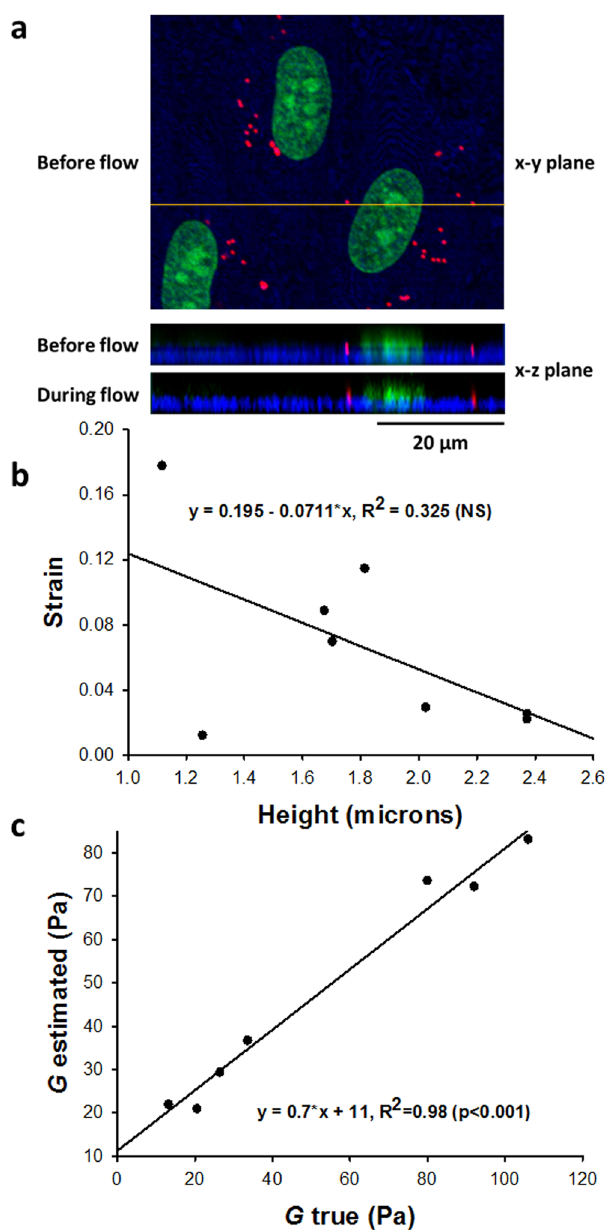
Figure 4. Estimation of endothelial cell shear modulus. ( a ) Confocal image of beads on top of the cells. The top image shows the glass (dark blue), nuclei (green) and beads (red) in the x-y plane. The middle image correspond to the x-z plane view of the same volume taken along the yellow line on the top image. Notice the two beads and the nucleus. The bottom image shows the same x-z plane view during shear flow in the x direction. Bead displacements in the x-z view are possible to detect. However, on the x-y plane the beads are circular and sub- pixel resolution displacements can be detected by computing the center of mass of the beads. The x-z view allows the measurement of bead distance from the top surface of the glass. ( b ) Shear strains obtained as the bead displacement due to flow divided by the height of the bead (Y position) as a function of height. There was not a significant correlation between shear strain and height. ( c ) Correlation between the shear modulus estimated by assuming a mean cell height for shear strain and “true” shear modulus using the actual height obtained from the confocal